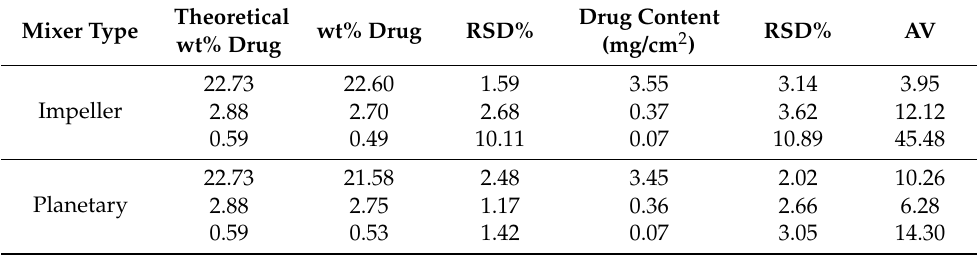
Table 4. Average values and RSD% of dried-films at varying drug concentrations (wt%), drug content per unit area along with acceptance values (AV).